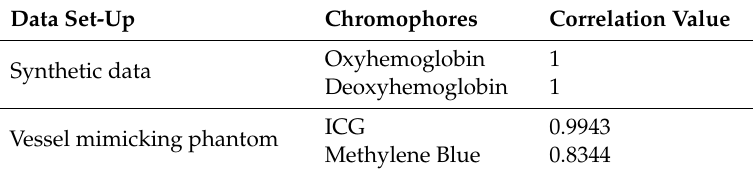
Table 1. Correlation values between the extracted source components by using the NNMF unmixing approach, and the respective absorption spectral curves used as a